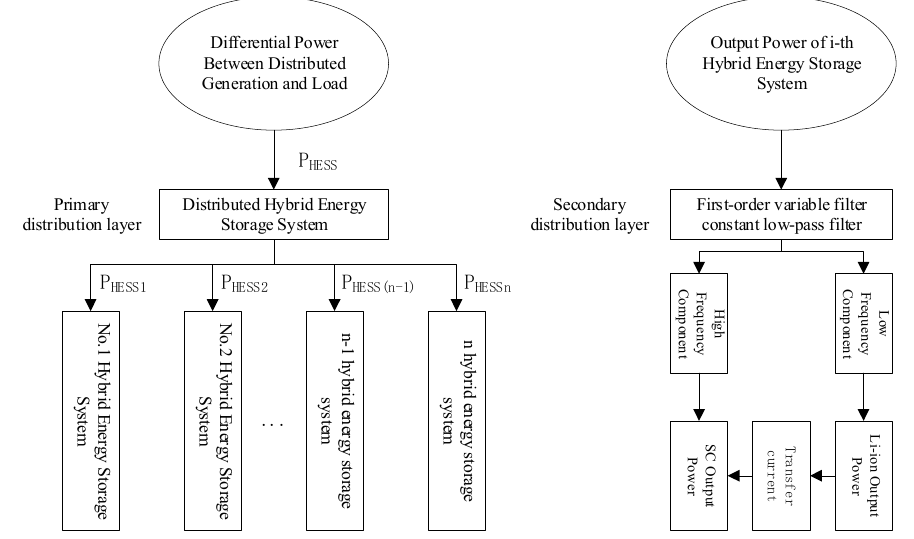
Figure 2. Hierarchical Control Strategy Structure of Distributed Hybrid Energy Storage System.